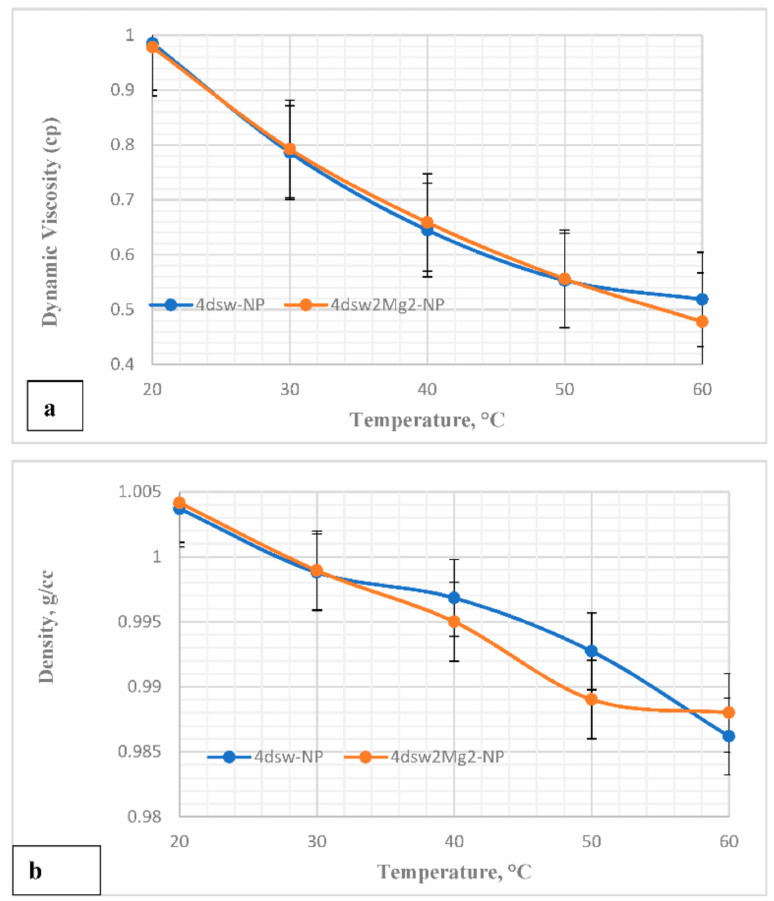
Figure 8. ( a ) Viscosity-temperature relationships for EW-NF; ( b ) density-temperature relationships for EW-NF.